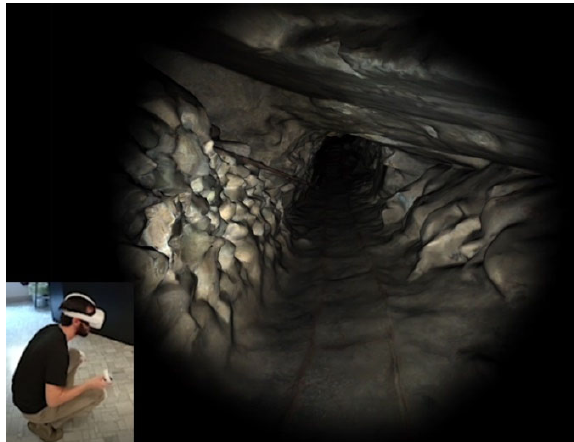
Figure 13. Interaction with the demo VR application. The VR headset allows the users to immerse themselves inside the closed mines and interact in the virtual environment the most similarly to how they would